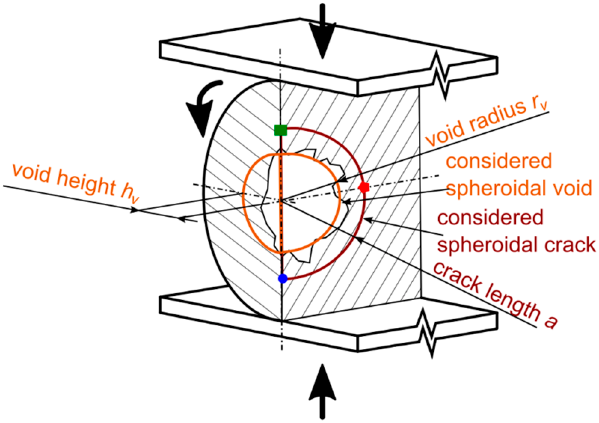
Figure 4. Model of a bearing cylinder with an initial spheroidal void in the middle.